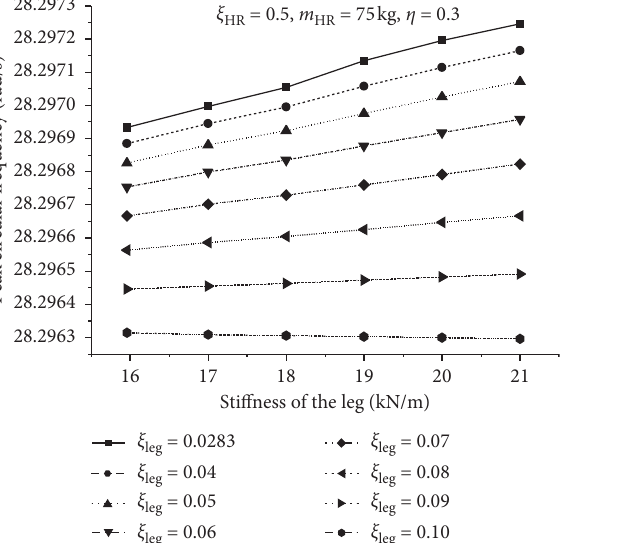
Figure 32: Peak frequency under ξ